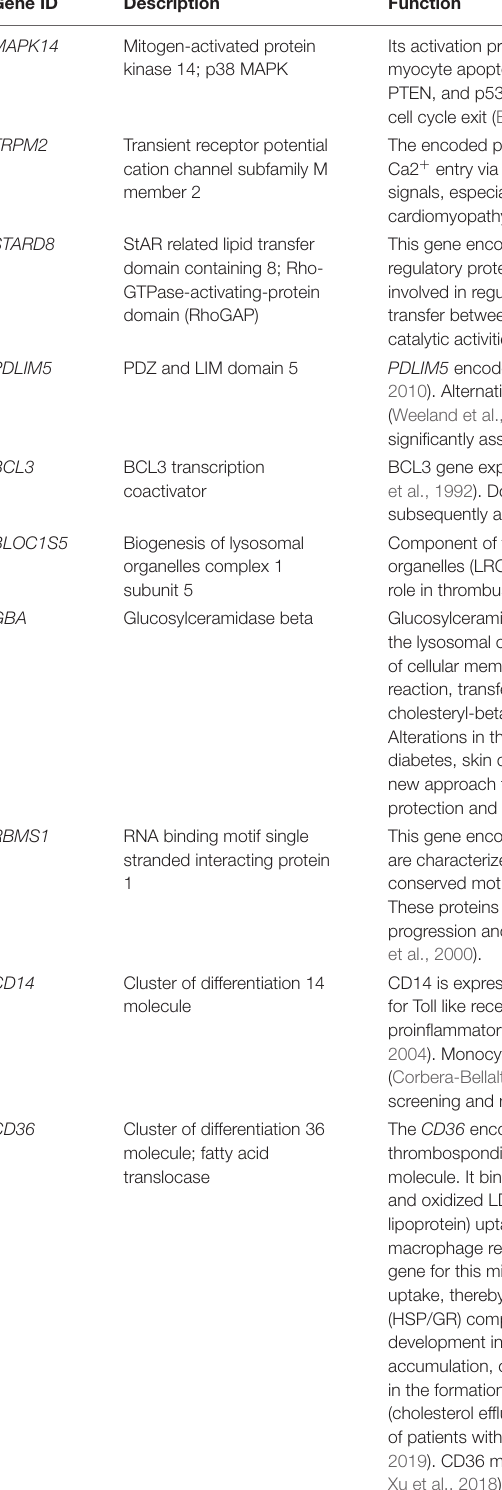
TABLE 4 | Description and potential functions of 10 genes selected from the 55 intersecting genes expressed in both FH and FH-CHD but not in N, H, and CHD groups. Gene ID